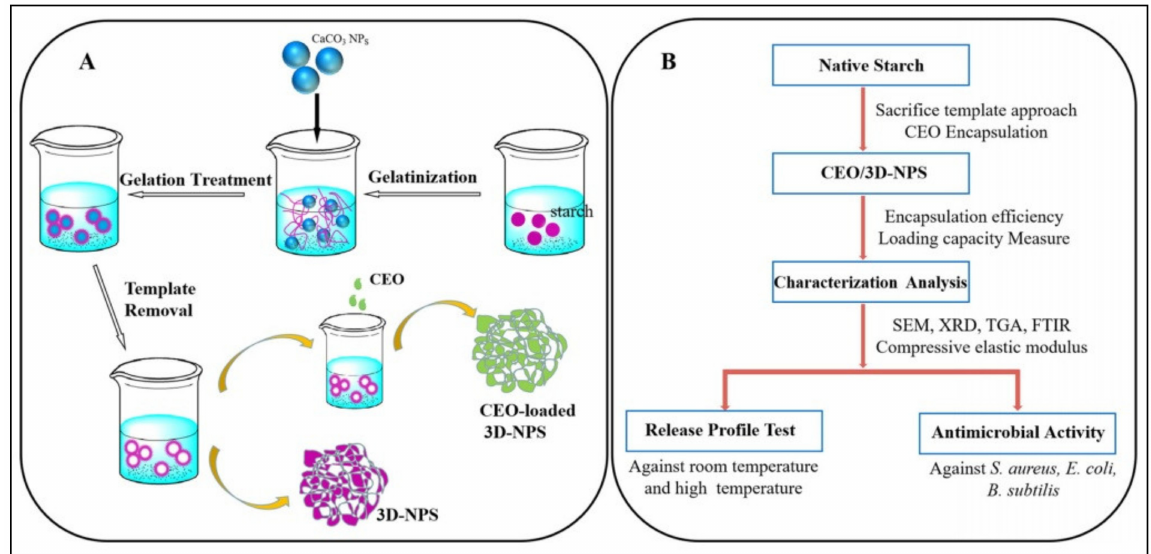
Figure 4. Illustration of the 3D-nanoparticles formation for the clove EO encapsulation ( A ), and the experimental flowchart ( B ). Reprinted with permission from ref. [132]. Copyright 2019, Elsevier